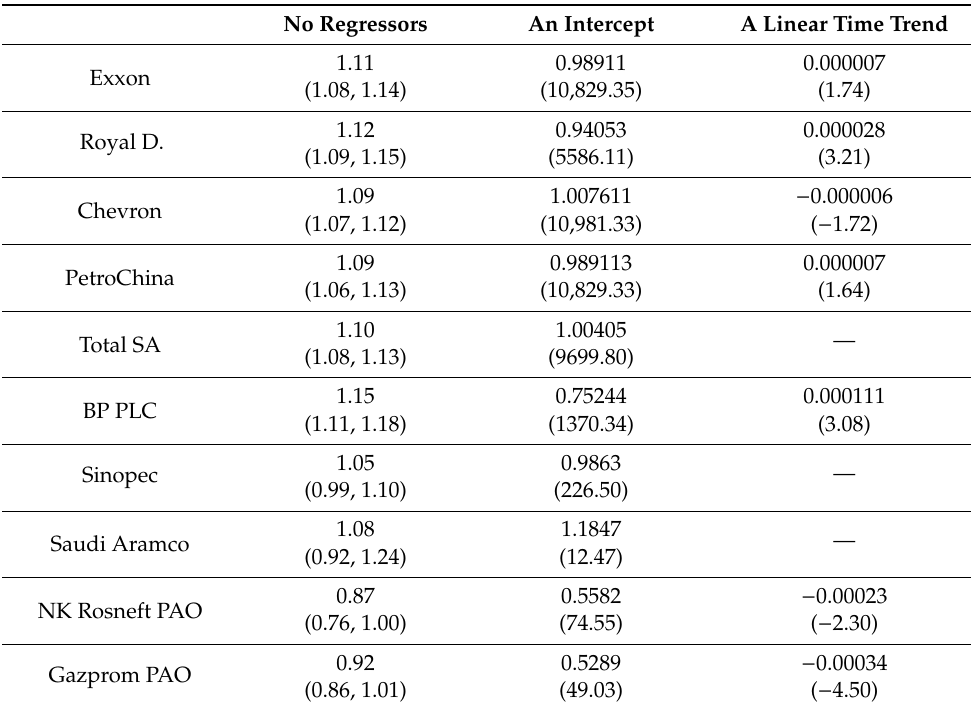
Table 3. Estimated coe ffi cients for the selected models in Table 2 with white noise.